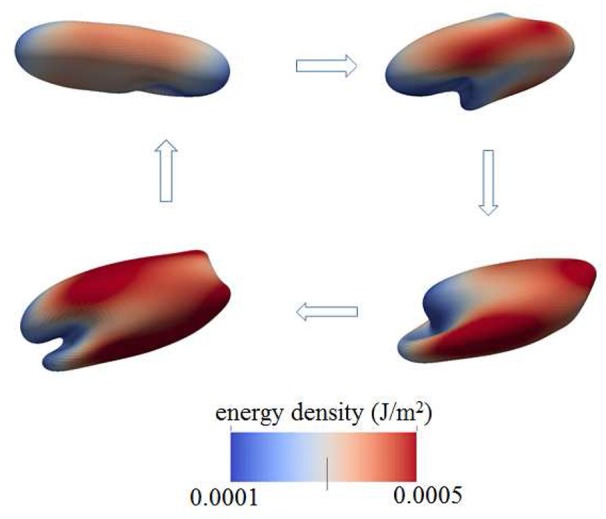
Contours of skeleton energy density, χ, in an oscillatory shear flow field. The shear rate was σ = 5,000s−1 at a frequency of 67 Hz. The cytosolic/medium viscosity ratio is 5; the average shear stress applied to the cell was in the range τ¯~6Pa. The energy densities range from about 1 × 10−4Jm−2 (blue)−5 × 10−4Jm−2 (red).